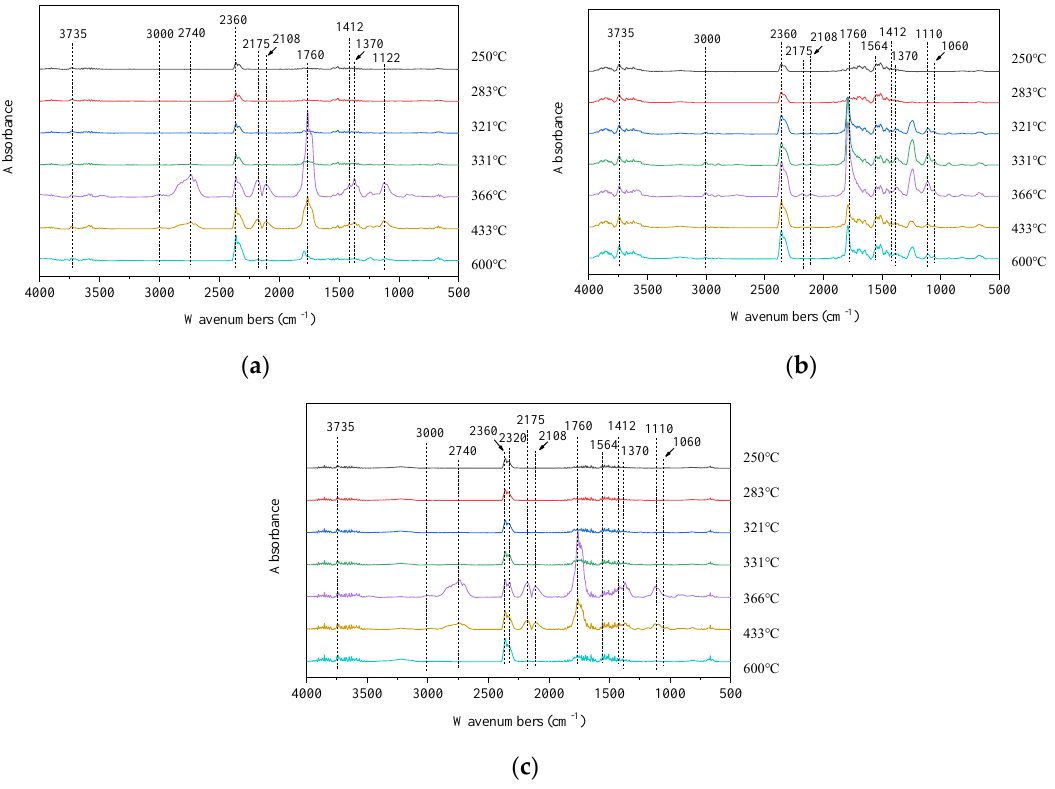
Figure 4. Three-dimensional thermogravimetry-Fourier transform infrared spectrometry (TG-FTIR) spectra of gaseous products in the thermal decomposition of PLA and flame-retardant composites: